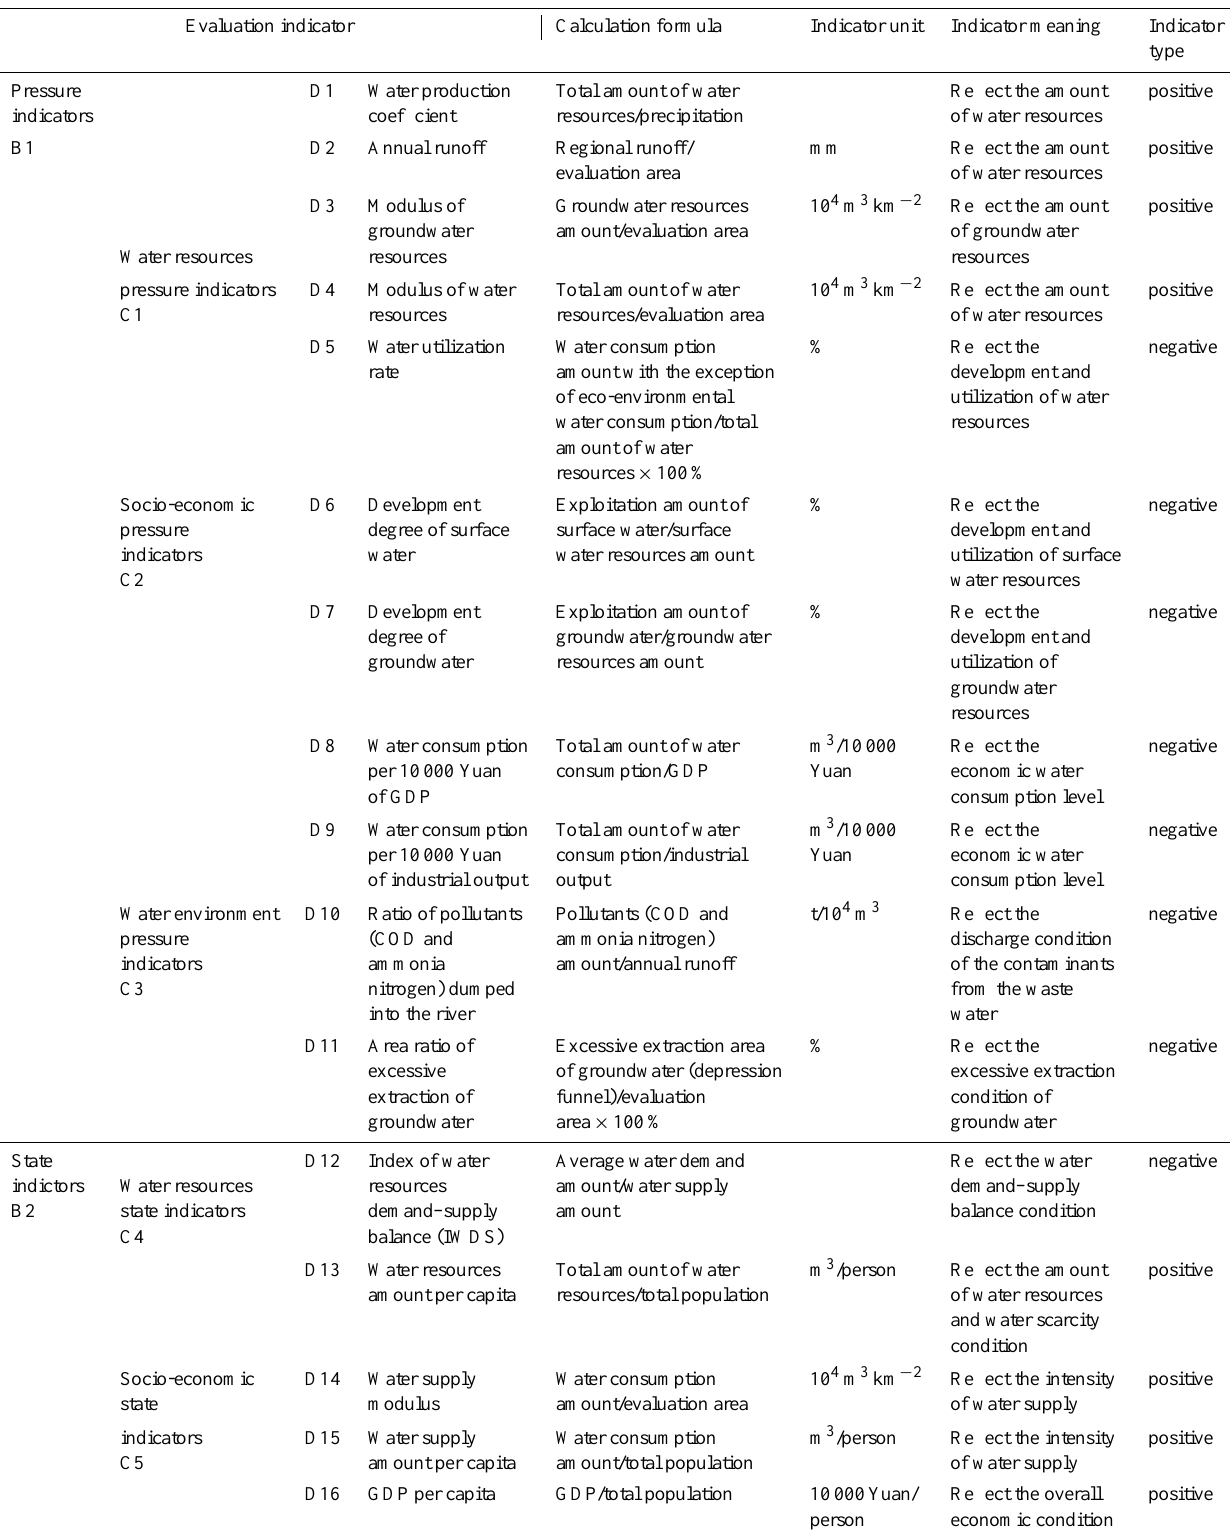
Table 1. Water resources security evaluation